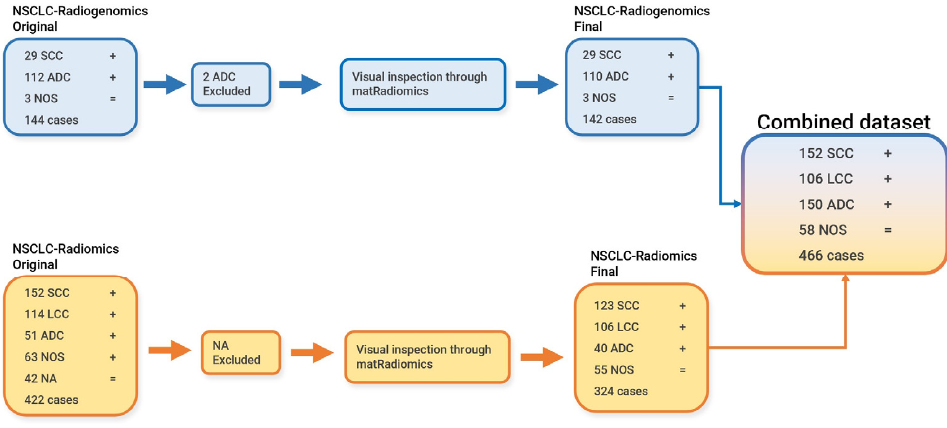
Figure 1. Data preparation